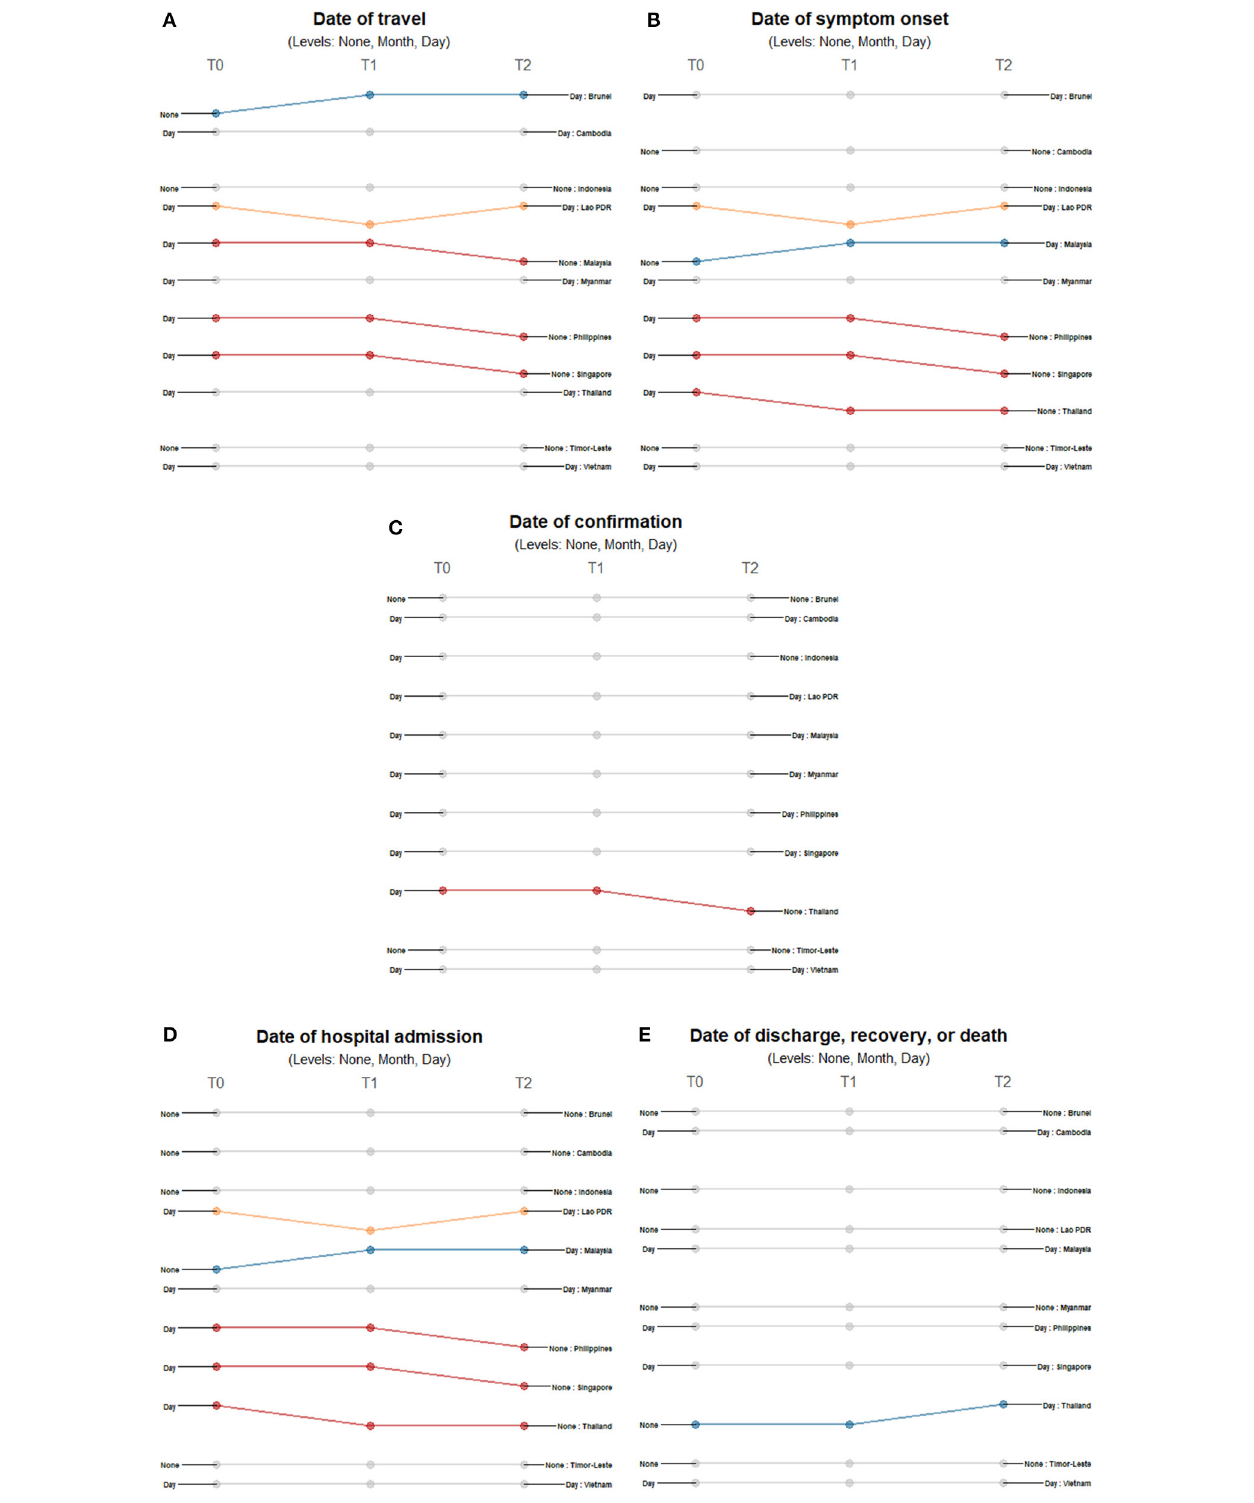
FIGURE 4 | Differences in the level of precision in reporting temporal data: (A) date of travel, (B) date of symptom onset, (C) date of confirmation, (D) date of hospital admission, and (E) date of outcome over three timepoints. Only those countries with changes in the level of detail and precision of reporting are